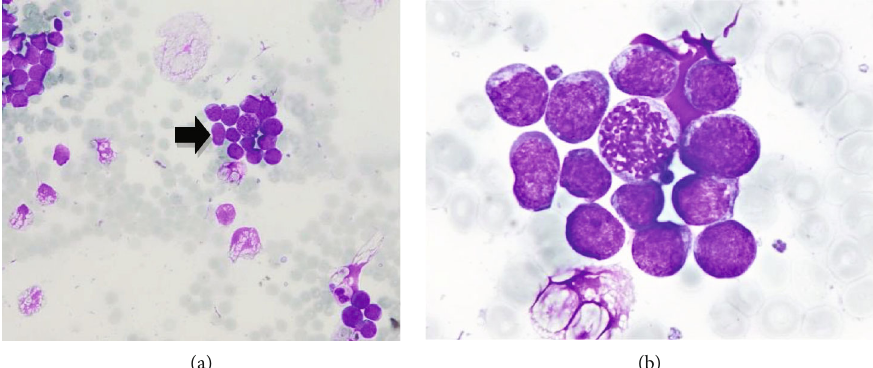
Figure 1: Bone marrow aspirate. Numerous blast cells (arrow) with scant, basophilic cytoplasm containing occasional vacuoles are shown (May-Grünwald-Giemsa: (a) 200x and (b) 1000x).